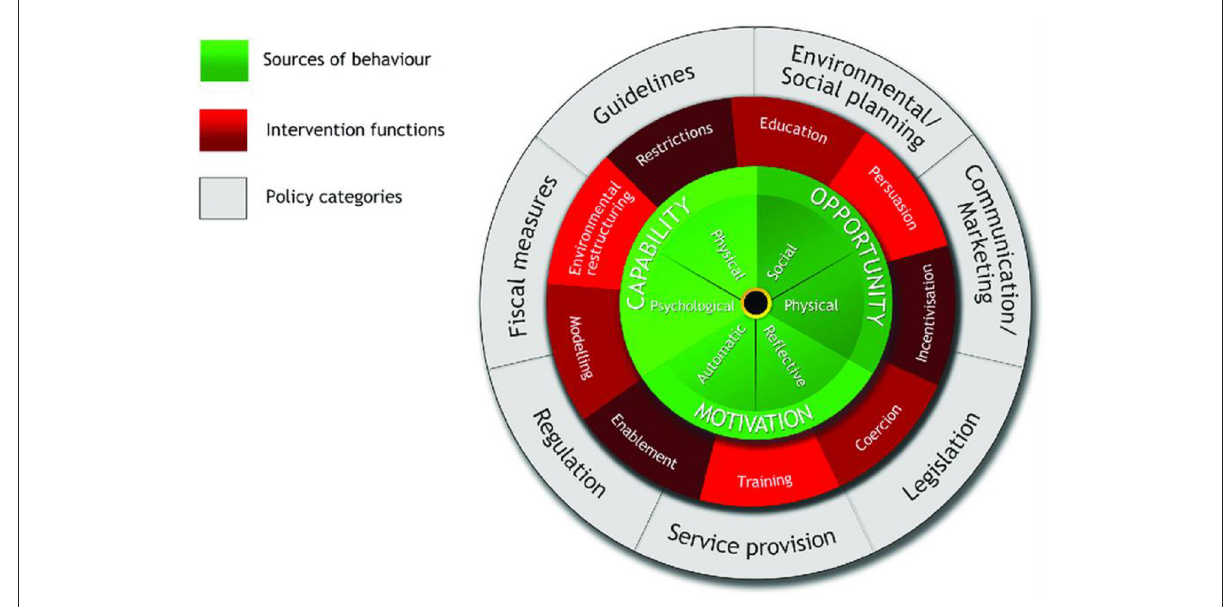
FIGURE2 The Behaviour Change Wheel (Michie et al., 2011,